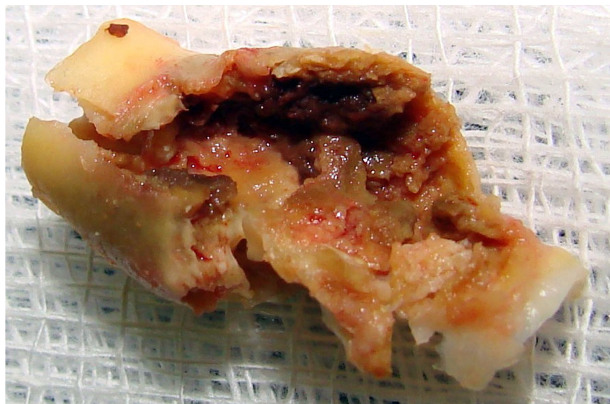
Fig. 3 - Example of cholesterol plaque removed from the internal carotid artery.